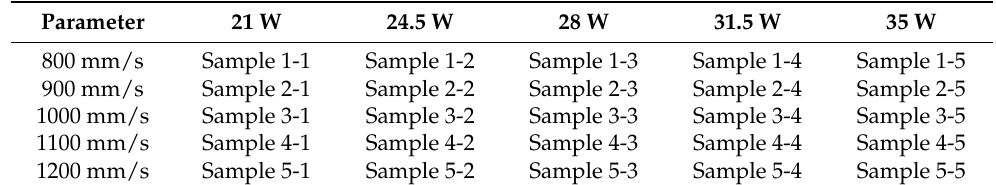
Figure 2. ( a ) Measuring the HAZ around the cutting hole with the microscope; ( b ) measuring the surface roughness with the laser confocal microscope. Table 2. Experimental design of CFRP laser cutting.